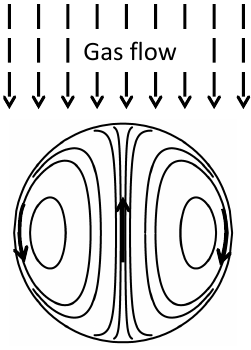
Fig. 1. 2-Dimensional representation (cross-sectional view though the center of the drop and parallel with the gas flow) of the theoreti- cal internal flow patterns for a liquid spherical drop as it falls at ter- minal velocity through a stationary fluid (Hadamard, 1911; LeClair et al., 1972). The dashed arrows represent the direction of the gas flow and the solid arrows represent the direction of the internal flow (i.e. streamlines). The 3-dimensional flow is axisymmetric about an axis directed towards the pole of the sphere along which the gas